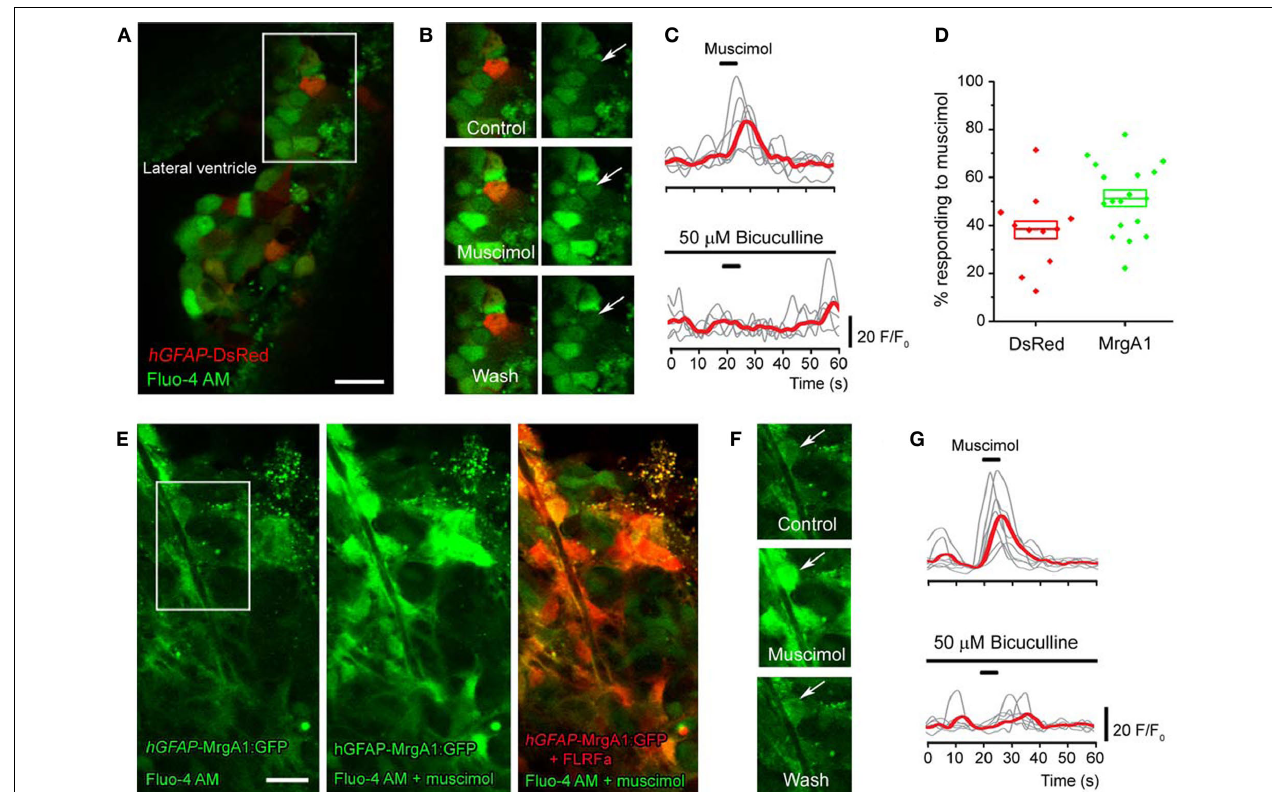
FIGURE 3 | GABA receptors regulate Ca 2 + dynamics in SVZ astrocytes. diamonds: individual slice values. (E) Confocal image (one optical section) of A (A) Z-stack confocal image (six images spaced by 1.5 µm) of Fluo-4 AM loaded Fluo-4 AM loaded SVZ cells (green) in a sagittal slice from a hGFAP -MrgA1:GFP SVZ cells in a coronal slice from a hGFAP -DsRed mouse. Scale bar = 10 µm. mouse. Second panel shows SVZ cells responding to muscimol. The last panel is (B) Confocal image of the same cells shown in the white square in (A) under an overlay of images from responses to FLRFa peptide (orange, indicating SVZ control conditions, during and following muscimol application. The arrow points astrocytes) and muscimol (green). Scale bar = 10 µm. (F) Confocal image of the to the DsRed-fl uorescent cell, which responded to muscimol. same cells shown in the white square in (E) under control conditions, during and (C) Representative muscimol-induced Ca 2 + responses under control and in the following muscimol application. The arrow points to the MrgA1:GFP-fl uorescent, presence of bicuculline (a GABA receptor blocker). The red trace represents the FLRFa-responsive cell, which also responded to muscimol. (G) Representative A average of the individual gray traces ( n = 7 cells). (D) Box plots of the percentage muscimol-induced Ca 2 + responses under control and in the presence of of GFAP-progenitors responding to muscimol in hGFAP -DsRed or hGFAP - bicuculline in cells from hGFAP -MrgA1:GFP slices. The red trace represents the MrgA1:GFP mice ( n = 9 and 17 slices, respectively). Box: SEM, bar: median, average of the individual gray traces ( n = 8